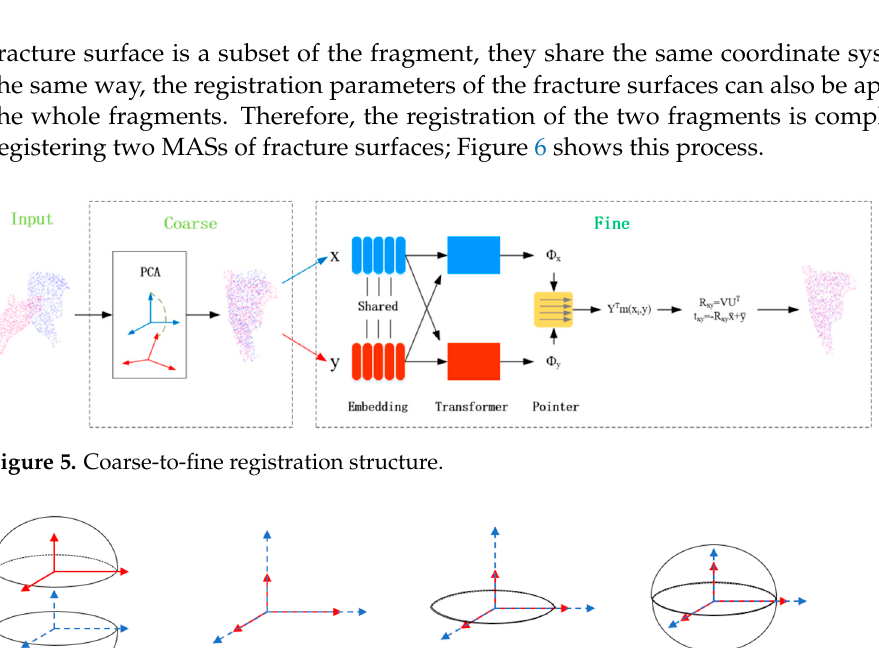
Figure 5. Coarse ‐ to ‐ fine registration structure.